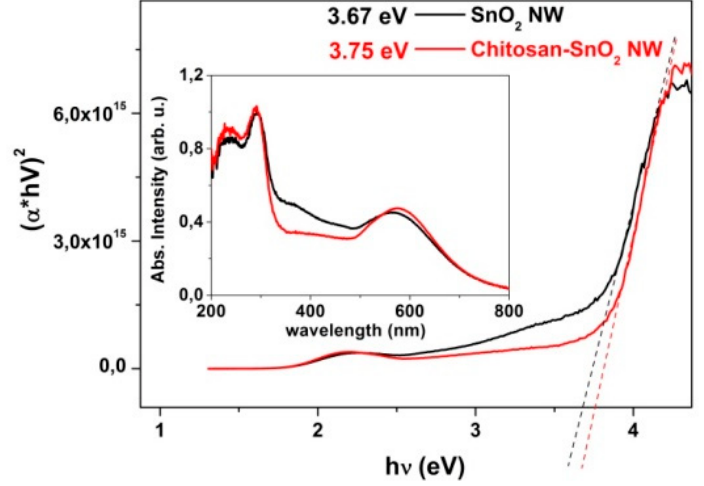
Figure 5. Tauc’s plot and UV–Vis absorbance spectra.